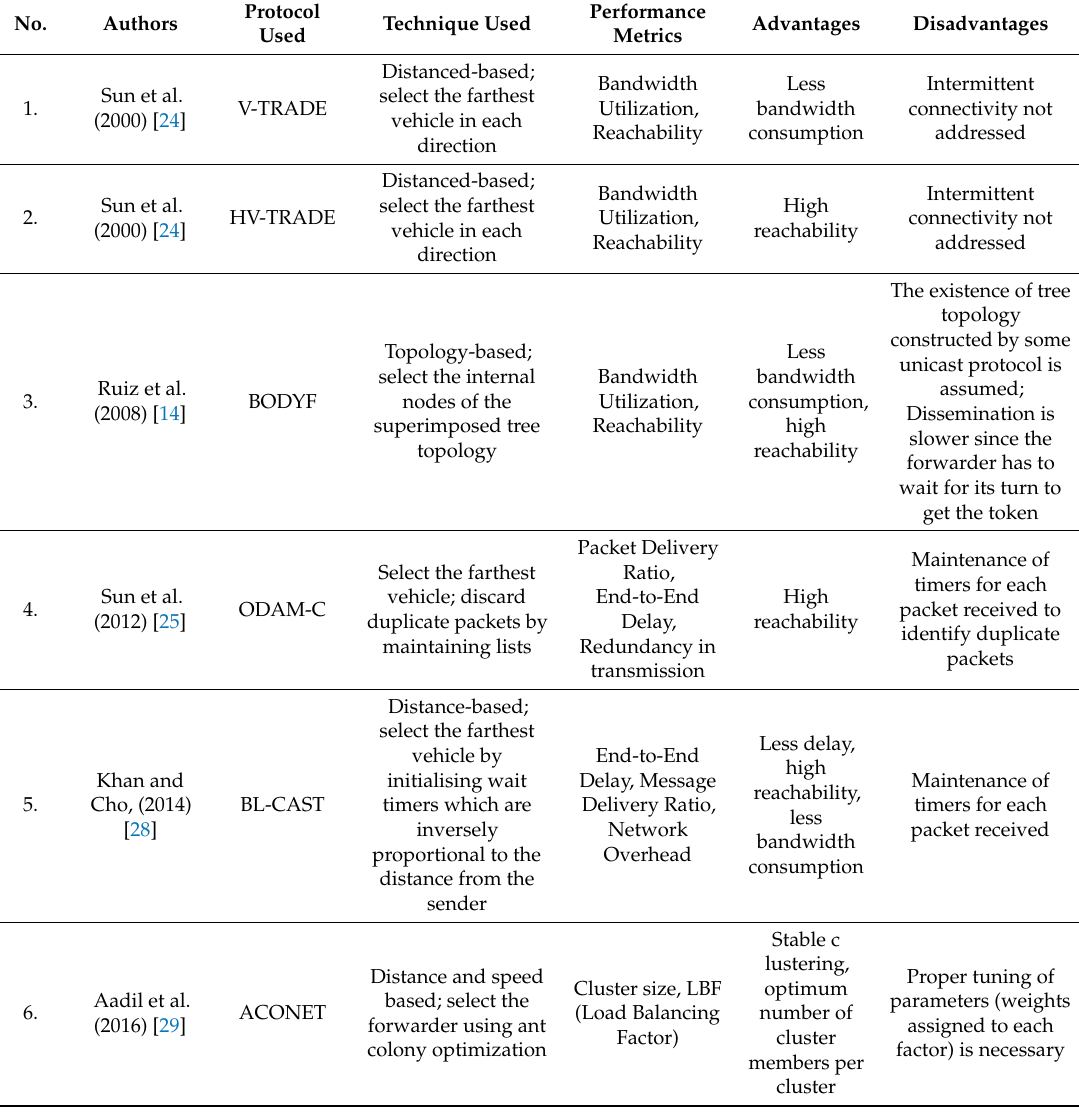
Table 1. Related